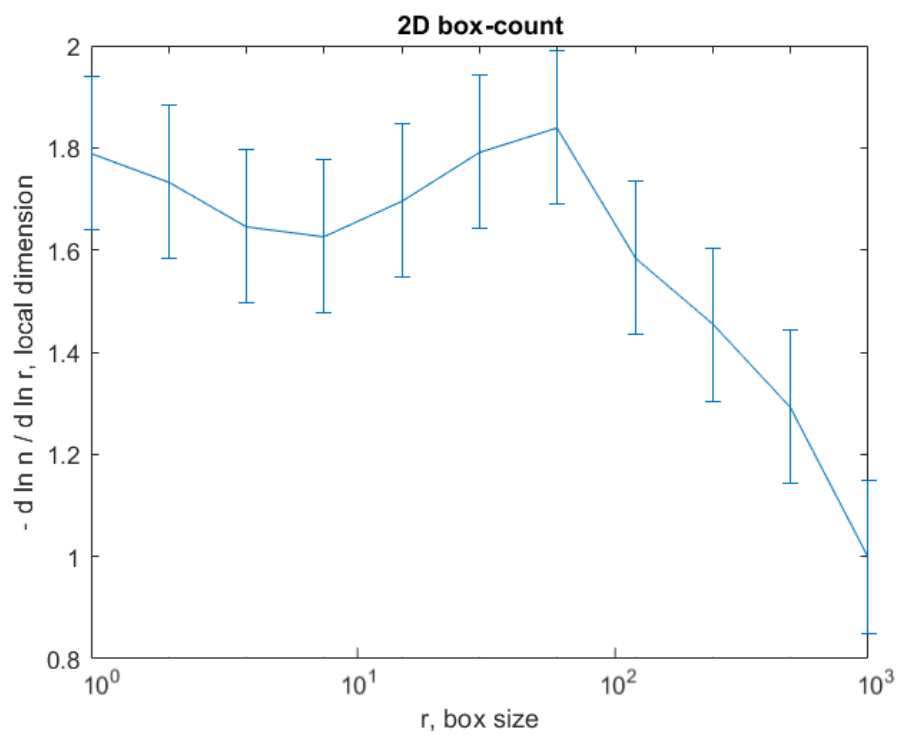
Figure 8. Box-count algorithm results: fractal dimension.